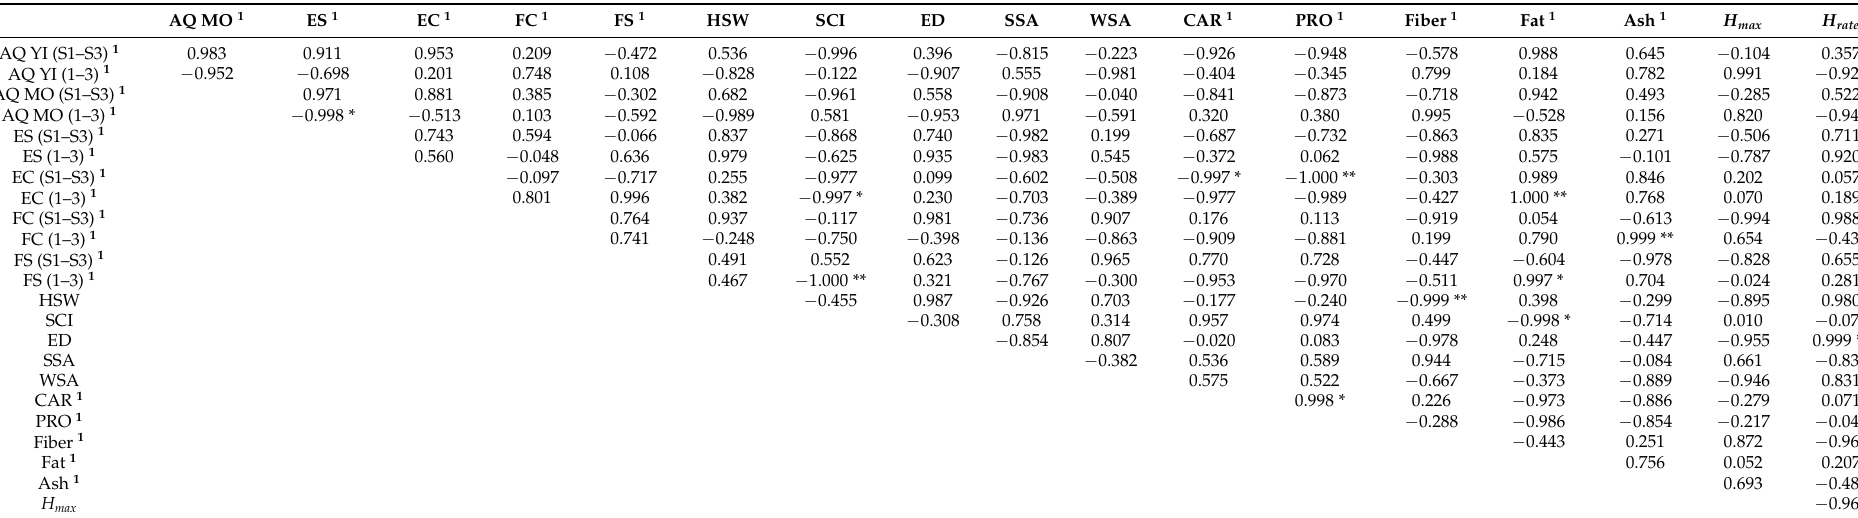
Table 5. Correlation coefficients among the physical, chemical, and hydration attributes for the three soybean cultivars and AQ yield, emulsion and foaming capacity, emulsion, and foaming